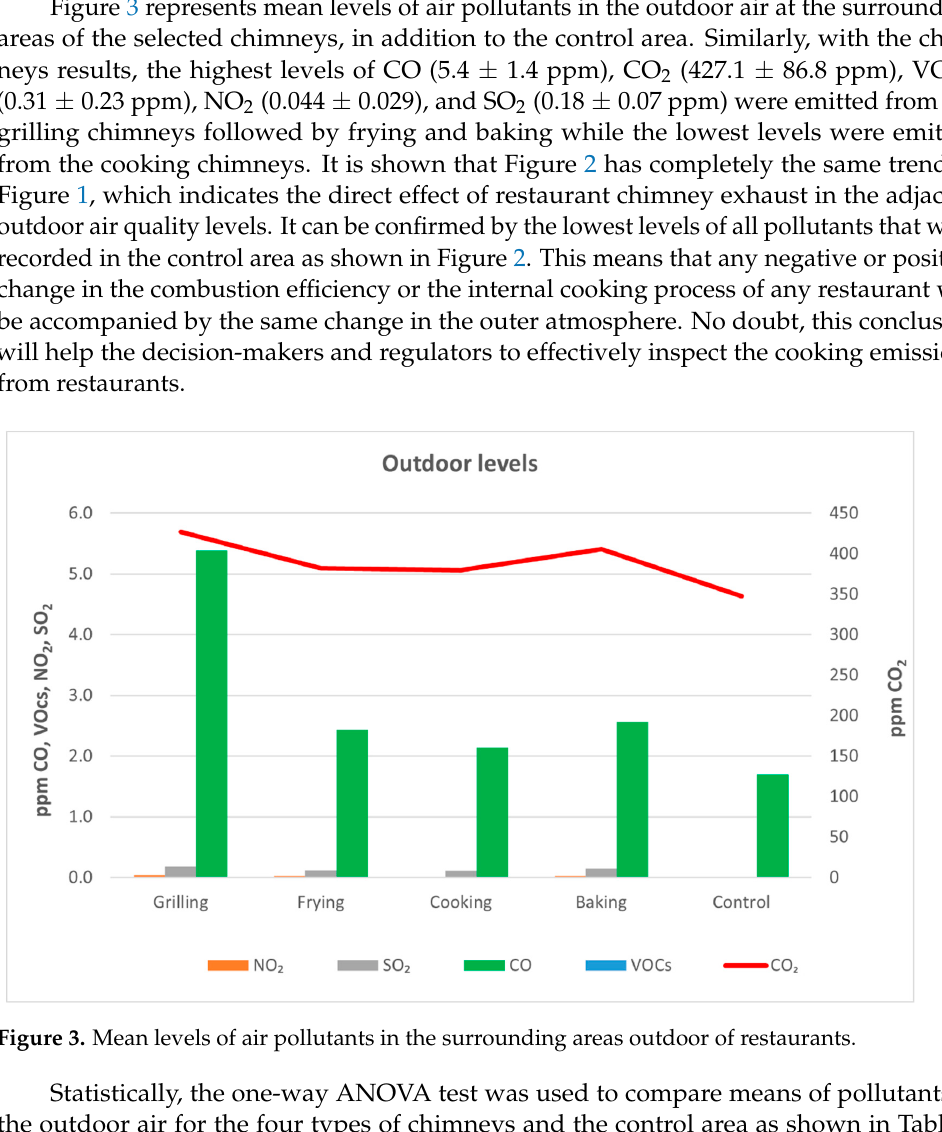
Table 5. One-way ANOVA test for mean levels of pollutants in the outdoor ambient air. Pollutant